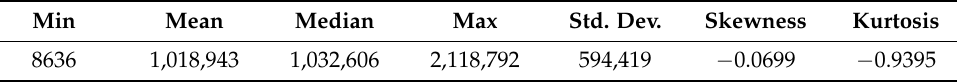
Table 2. Descriptive statistics of international pax traffic in AIA, January 2017 to July 2021. (The descriptive statistics for AIA were graphed with the KNIME Analytics Platform. All measures were calculated directly from the data sets.).